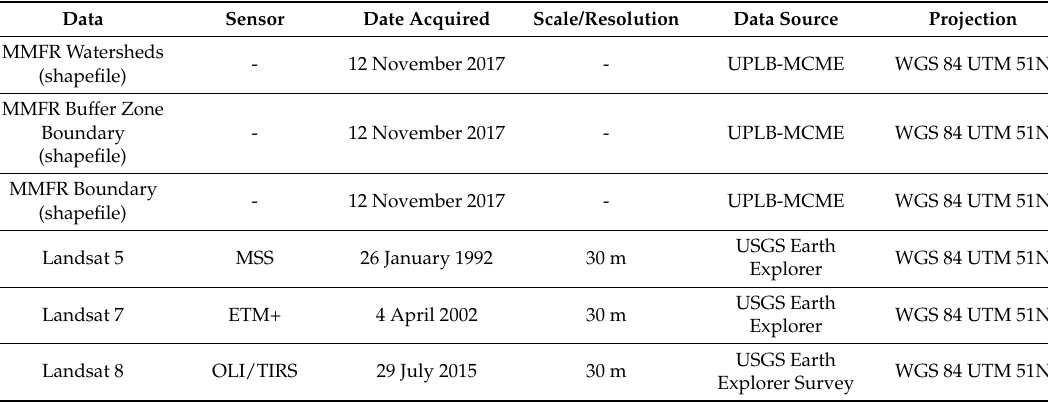
Table 2. Different data used in the